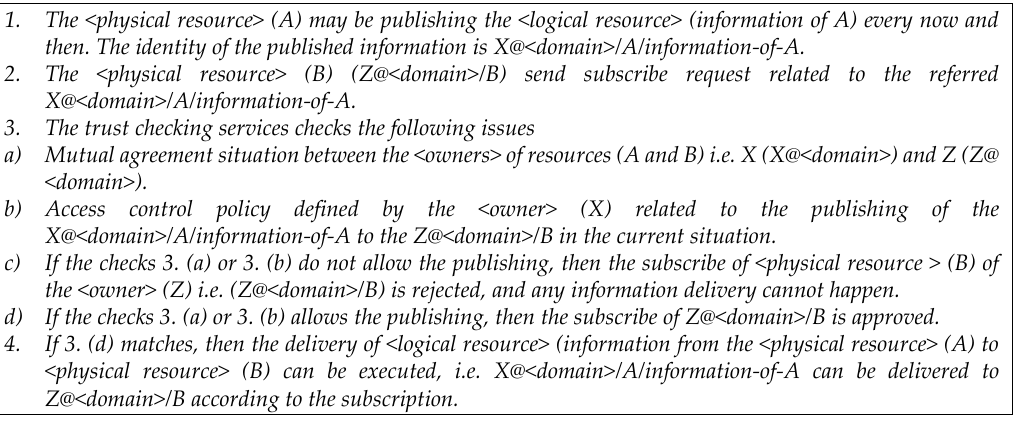
Figure 9. Information sharing algorithm.